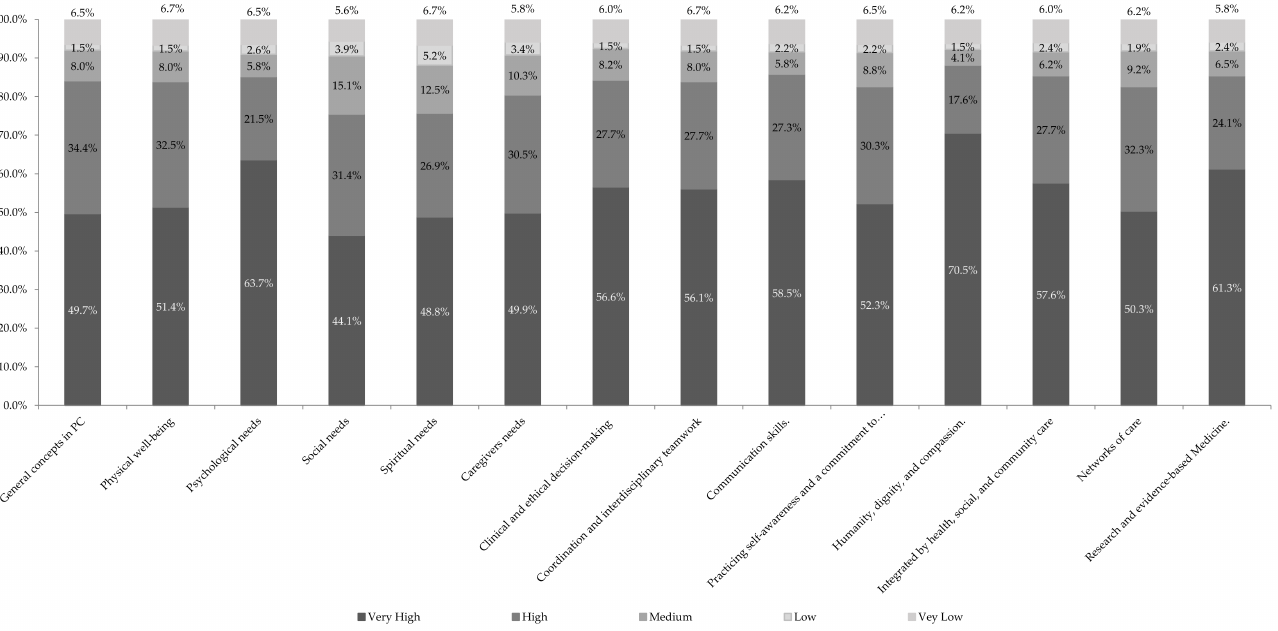
Figure 1. Priority level for competences to be developed in training related to Palliative